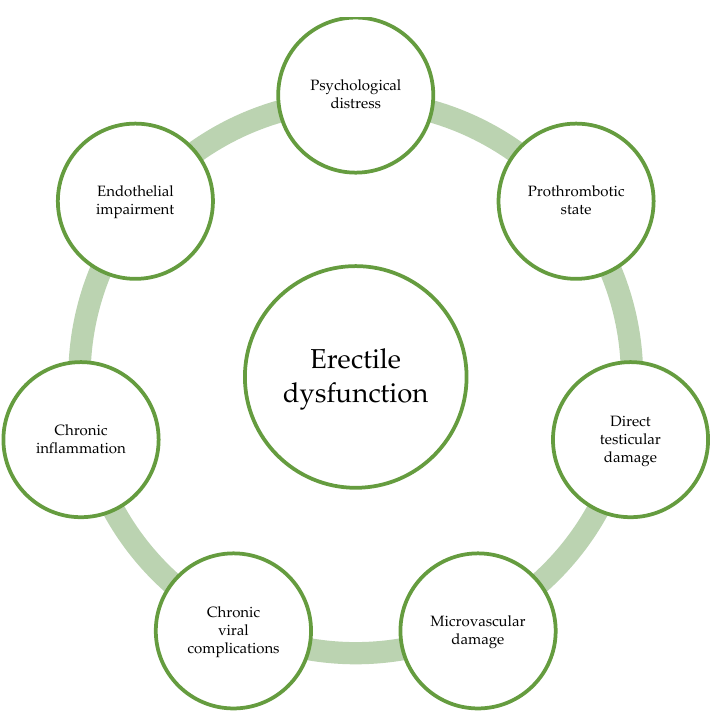
Figure 1. Different pathogenetic mechanisms by which COVID ‐ 19 could affect erectile function.